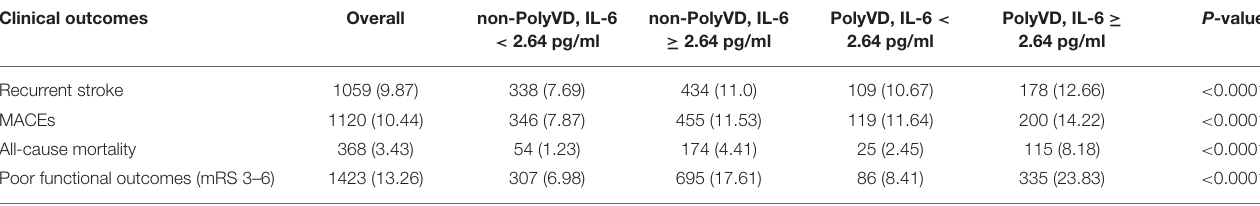
TABLE 2 | Clinical outcomes of patients included at 1 year follow-up.